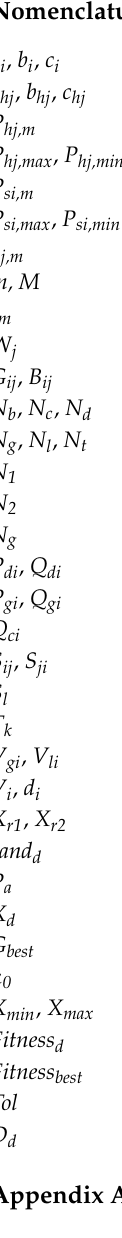
Table A1. Coefficients of cost function of four thermal units of the IEEE 30 buses